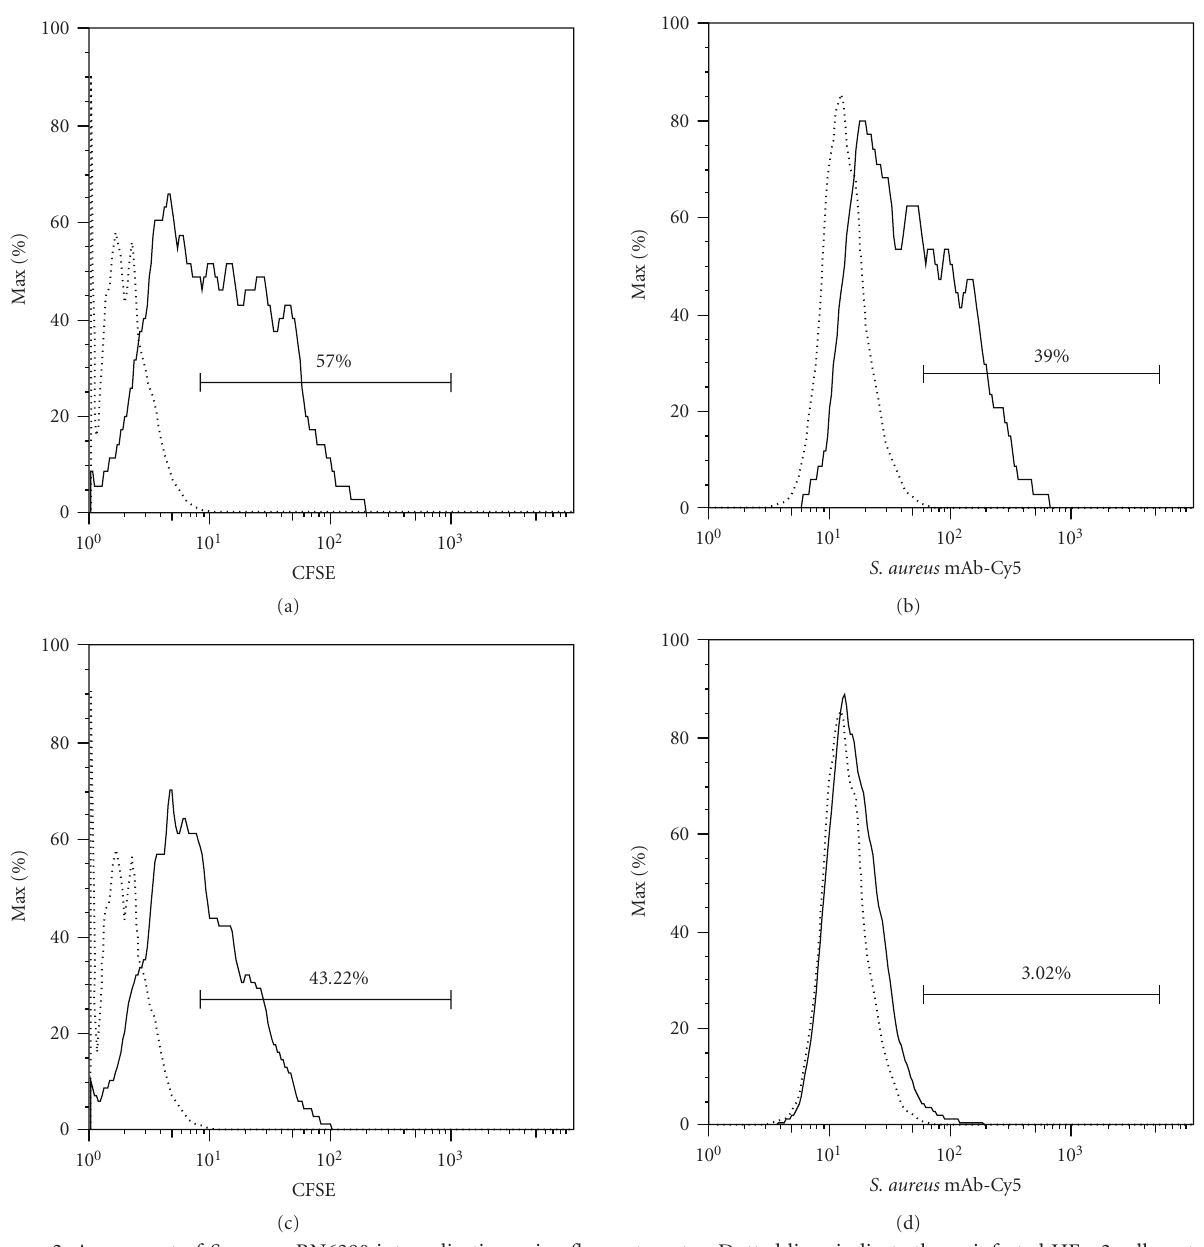
Figure 2: Assessment of S. aureus RN6390 internalization using flow cytometry. Dotted lines indicate the uninfected HEp-2 cell control, and solid lines indicate HEp-2 cells infected with CFSE-labeled S. aureus ((a) and (c)) or infected with CFSE-labeled S. aureus followed by labeling Cy5-conjugated mAb specific for S. aureus ((b) and (d)). In panels (a) and (b), HEp-2 cells were infected with CFSE-labeled S. aureus without treatment with lysostaphin. CFSE signal represents HEp-2 cells infected with extracellular and/or intracellular S. aureus (a). Cy5 signal represents HEp-2 cells infected with extracellular S. aureus only (b). In panels (c) and (d), HEp-2 cells were infected with CFSE-labeled S. aureu s followed by the treatment with lysostaphin which degrades staphylococcal cell wall causing a loss of CFSE signal by extracellular S. aureus . CFSE signal represents HEp-2 cells infected with intracellular S. aureus only (c). This was confirmed by showing the loss of Cy5 signal in panel (d). Data shown are from a representative experiment which was conducted three times.